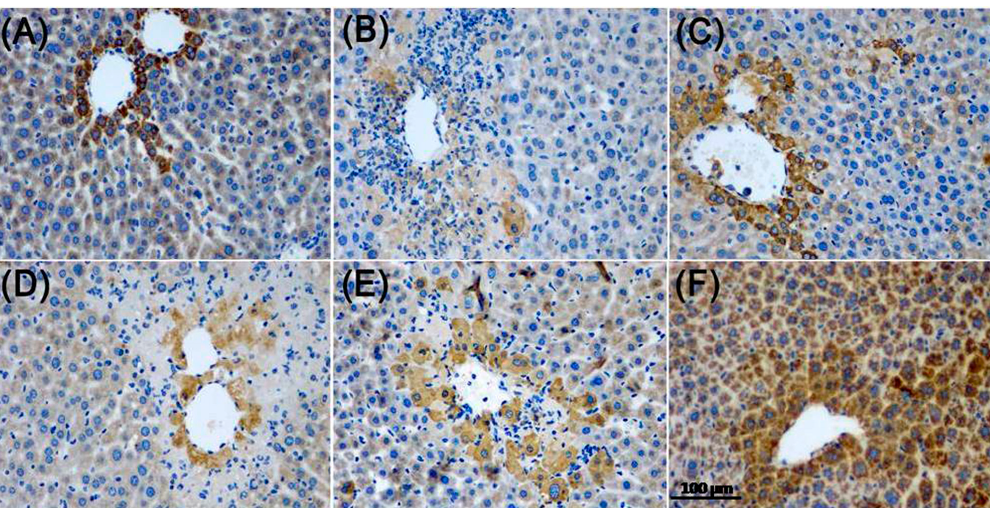
Figure 8. Effect of ZJF on Nrf2 expressions in the APAP-induced liver injury in mice. Photomicrographs were taken at 200×. ( A ) Control group; ( B ) APAP group; ( C ) Bifendate group; ( D ) ZJF-L group; ( E ) ZJF-M group and ( F ) ZJF-H group.